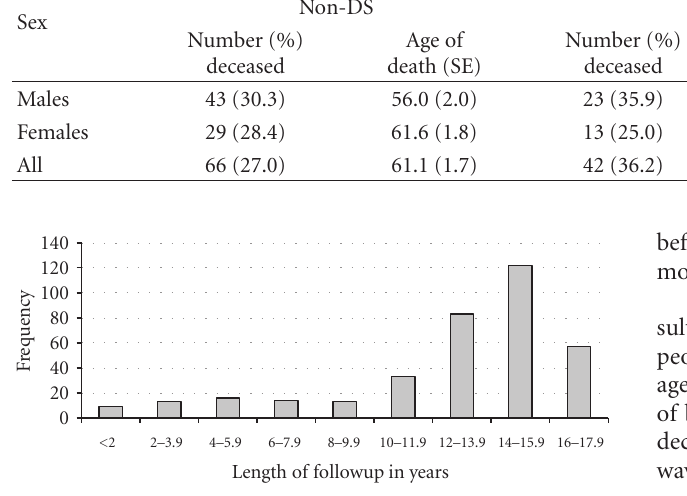
Figure 2: Length of follow-up of study participants by July